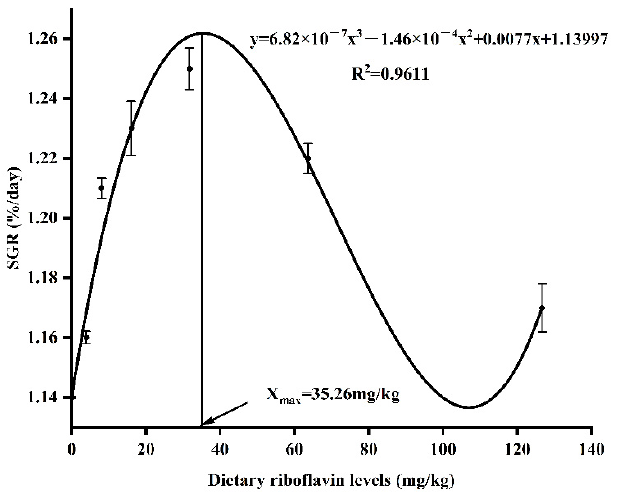
Figure 1. A cubic curve regression analysis of the relationship between specific growth rate (SGR) and dietary riboflavin level revealed that the optimal dietary riboflavin level was 35.26 mg/kg for coho salmon ( Oncorhynchus kisutch ) post-smolts. Table 2. Effects of graded dietary riboflavin levels on survival, growth performance and feed utili- zation of coho salmon ( Oncorhynchus kisutch ) post-smolts for 12 weeks.